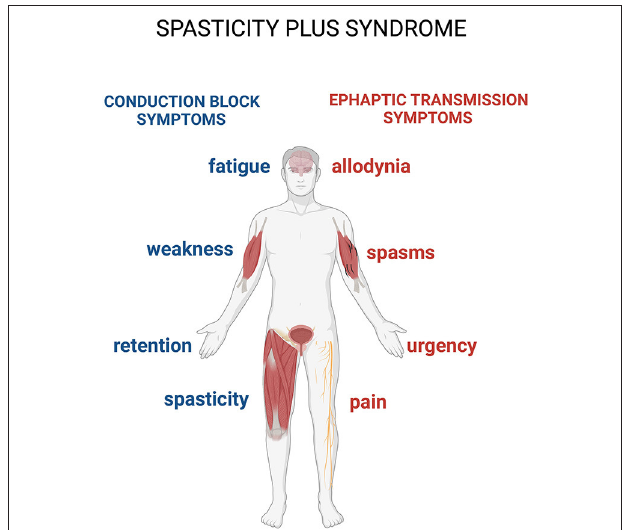
FIGURE 1 | The spasticity-plus syndrome (SPS) model characteristics. The new spasticity-plus syndrome, differently from the classical model, supports the hypothesis that spasticity, triggered by central nervous system (CNS) damage, and other symptoms caused by axon demyelination in terms of conduction block (spasticity, fatigue, weakness, and retention) and ephaptic transmission (spasms, pain, allodynia, and urgency) (see further in the text) are placed on the same level. This model implies that spasticity could be even milder compared to the other associated